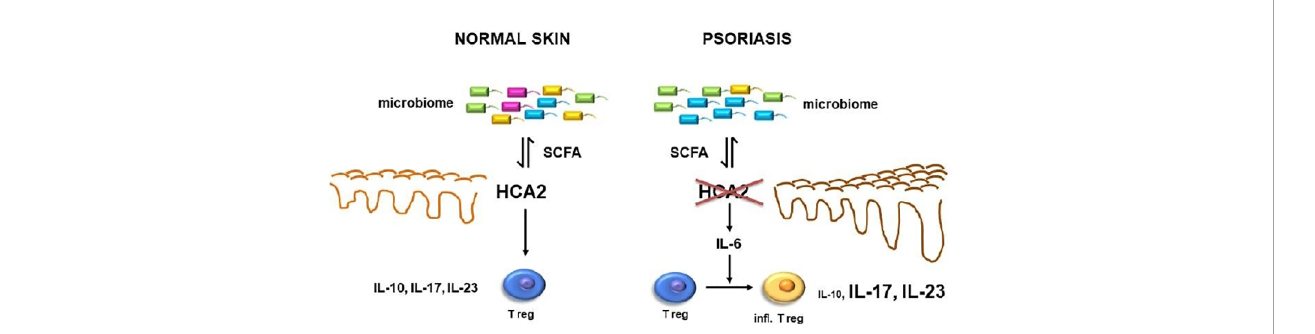
FIGURE 8 In psoriasis, reduced expression of HCA2 which may be mutually in fl uenced by an altered skin microbiome may result in enhanced expression of IL-6 which may switch Treg into a proin fl ammatory cell type. This appears to be associated with a reduced expression of IL-10 and an enhanced expression of IL-17 and